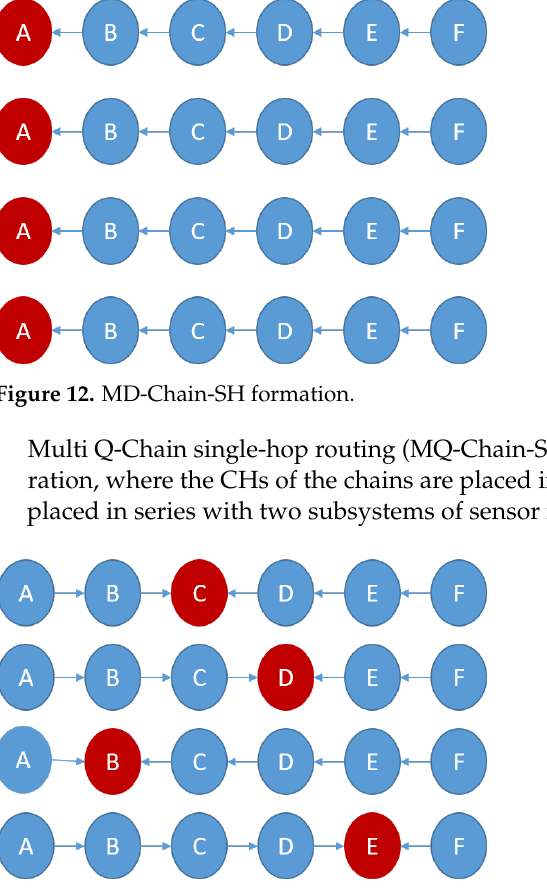
Figure 13. MQ-Chain-SH formation.